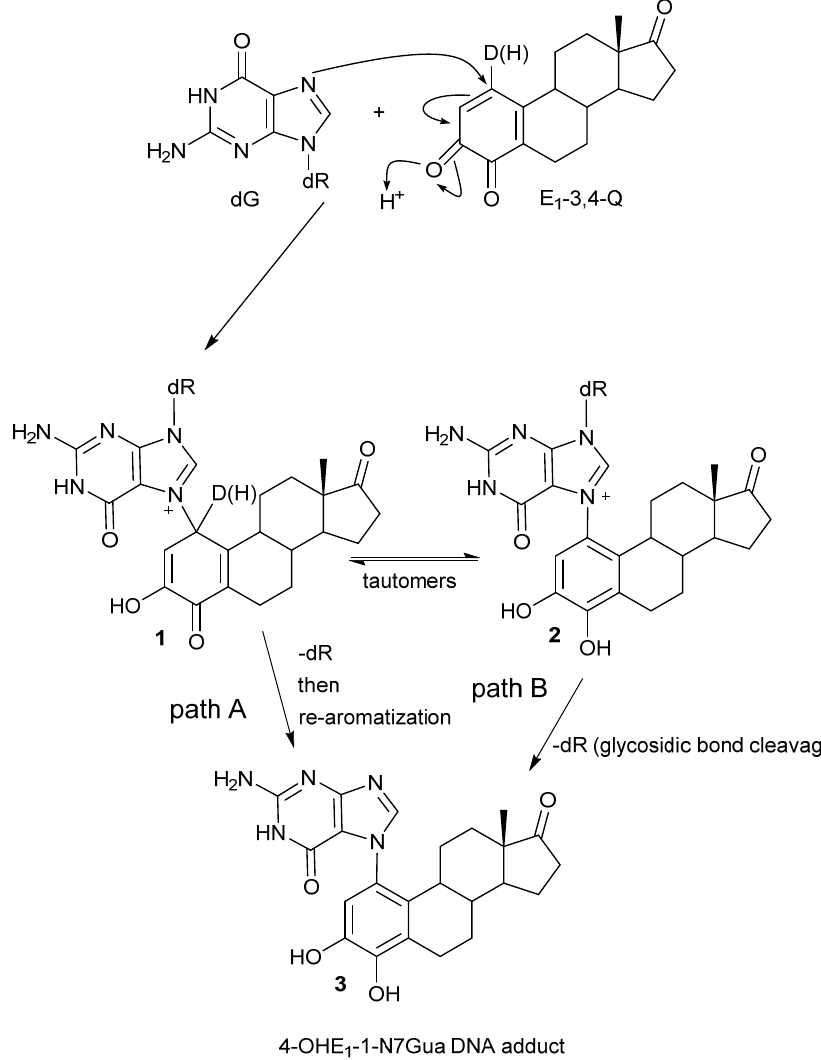
Figure 2. Possible mechanistic routes in the reaction of E 1 -3,4-Q (both deuterium labeled and unlabeled) with dG to form the estrogen-DNA adduct 4-OHE 1